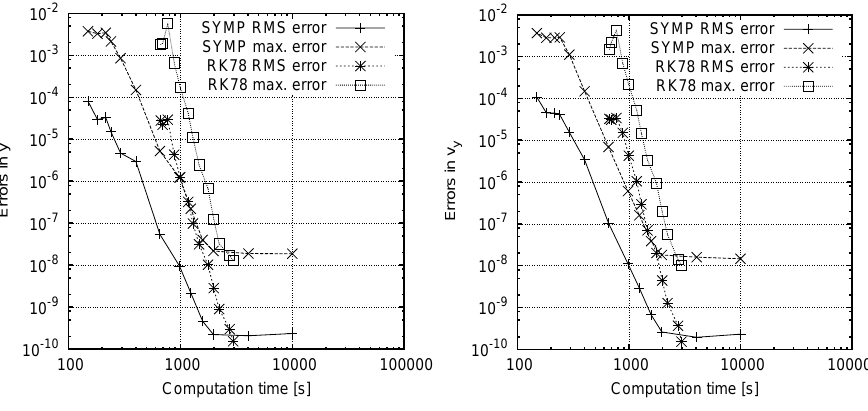
Fig. 17. The root mean square and maximum deviations of the y -coordinate and it’s derivative ˙ y from the linearly approximated invariant